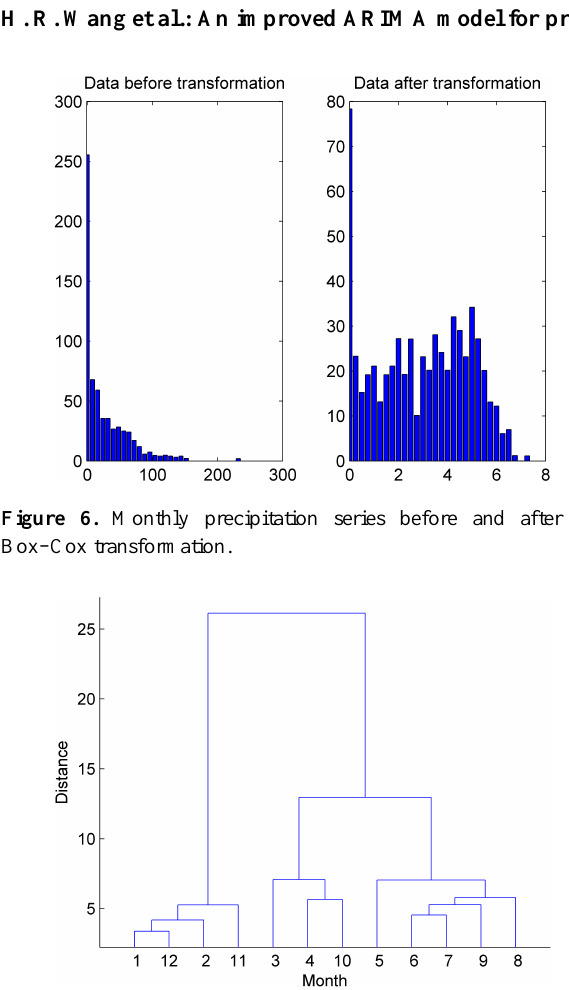
Figure 7. Clusters of monthly precipitation time series.